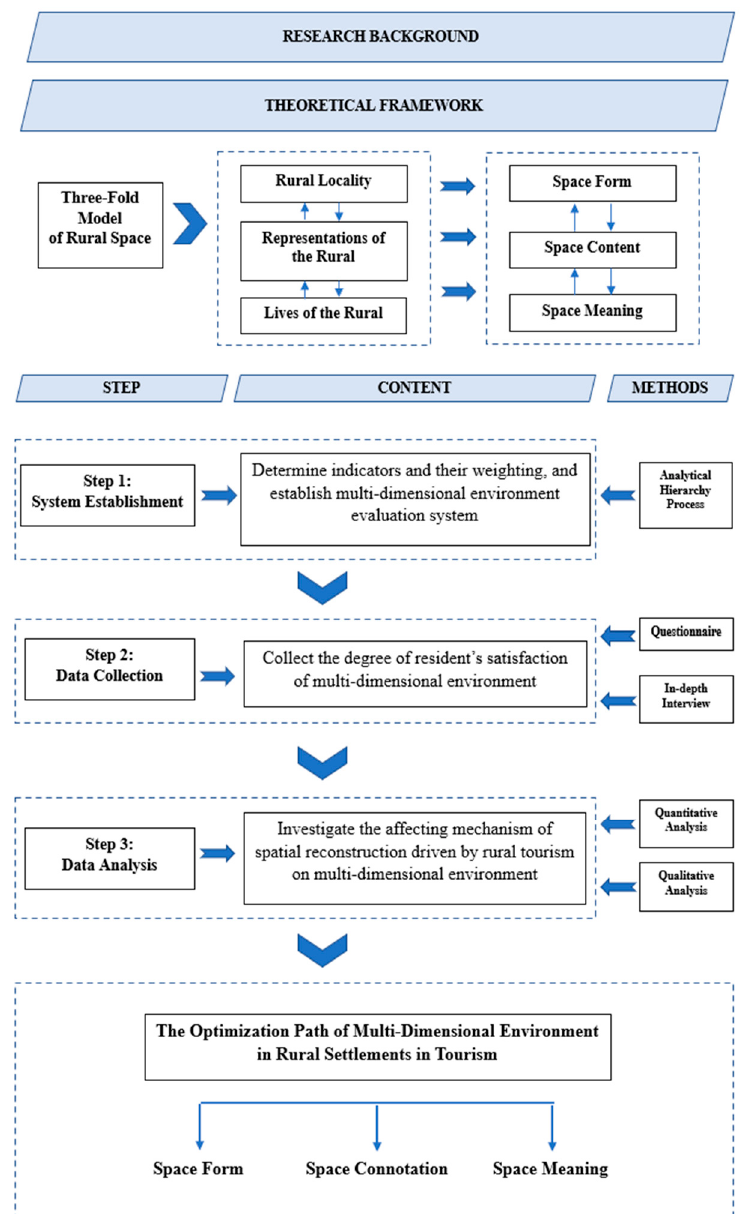
Figure 7. Research Figure 7. Research design.